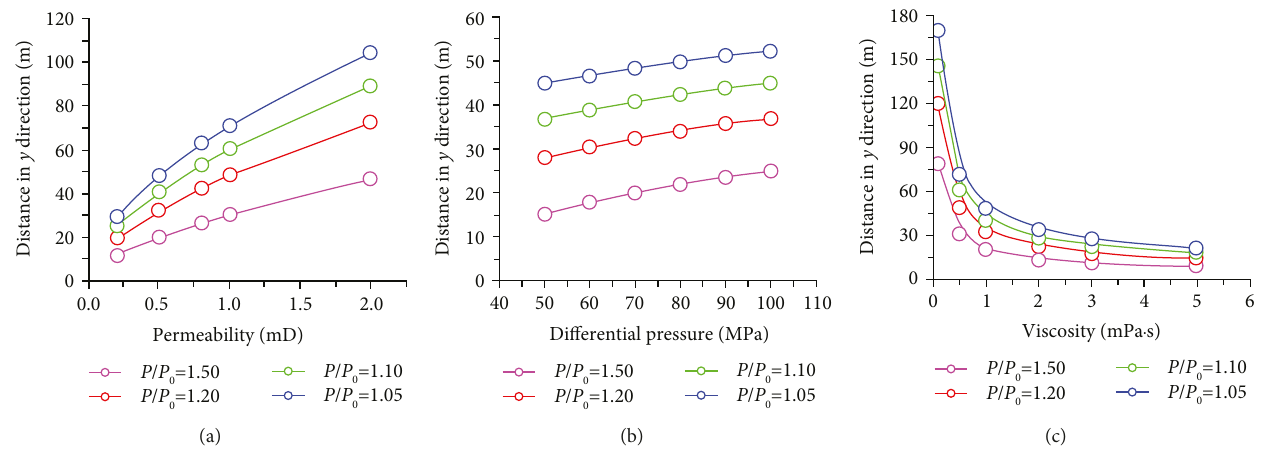
Figure 8: Di ff erent levels of pore pressure disturbance along the y direction from the fracture tip with the variation of (a) permeability, (b) di ff erential pressure, and (c)